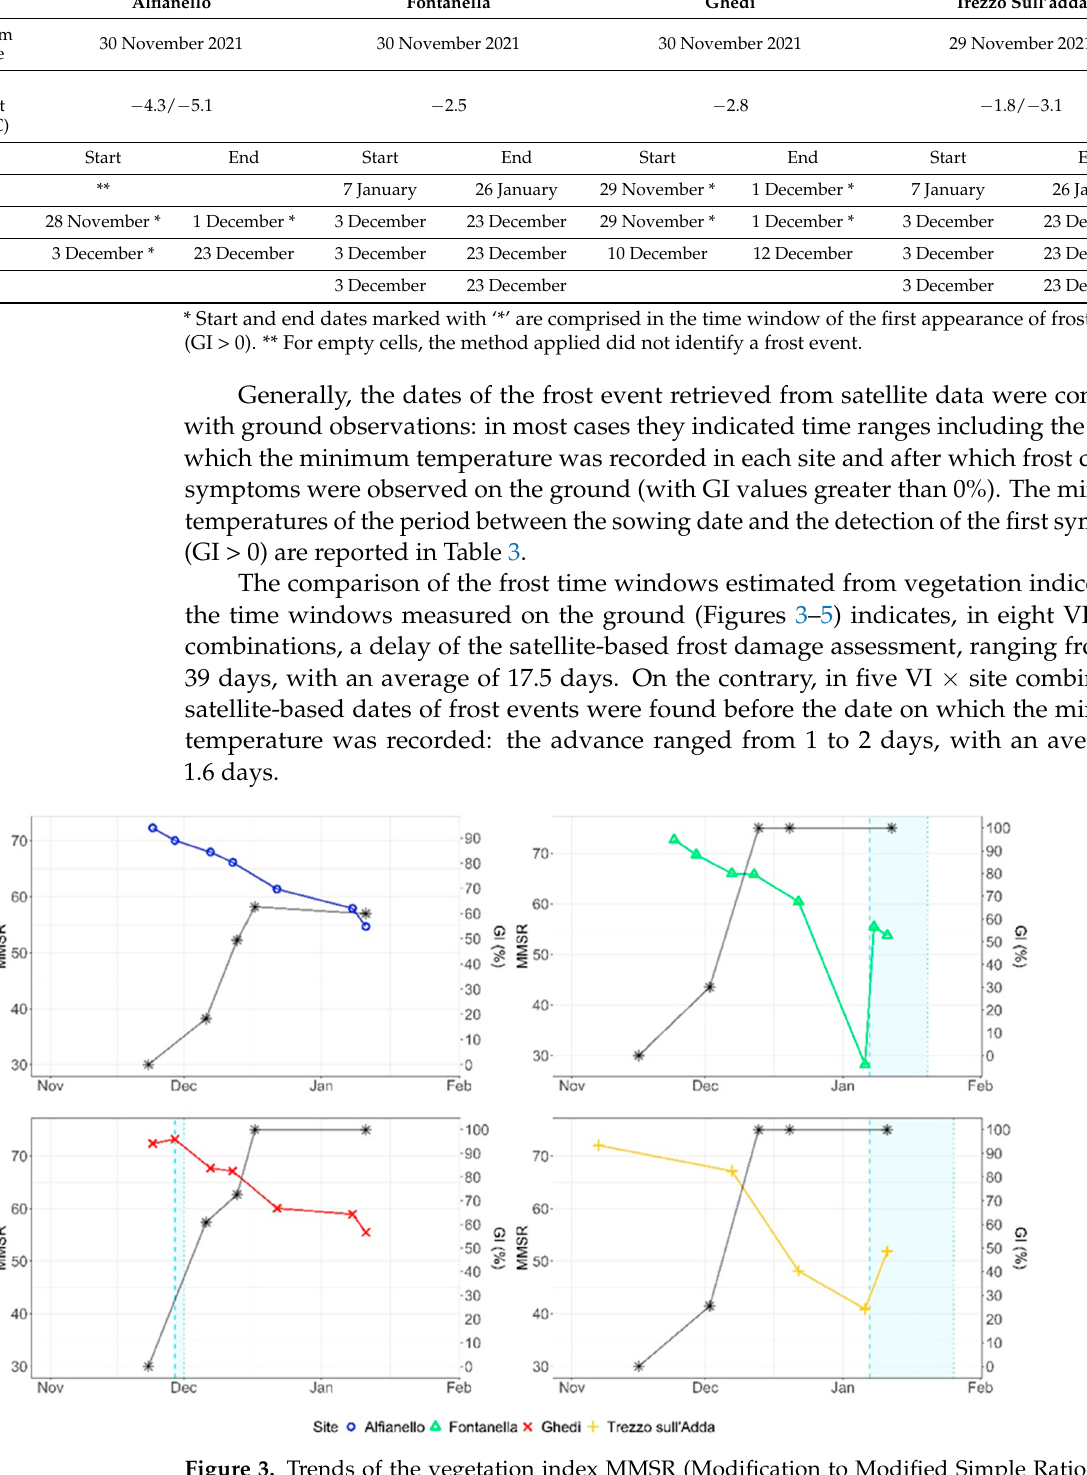
Figure 3. Trends of the vegetation index MMSR (Modification to Modified Simple Ratio) and of ground-measured frost index of a white mustard cover crop (GI, %) in the four monitoring sites. GI is represented with grey stars (*), the starting date of the first frost event estimated from MMSR with the ‘peak-based method’ is a vertical light-blue dashed line, while the end is a vertical light-blue dotted line.